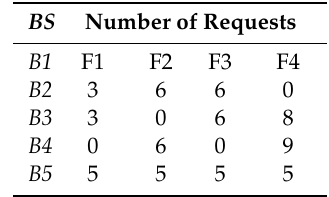
Table 1. Popularity Matrix.